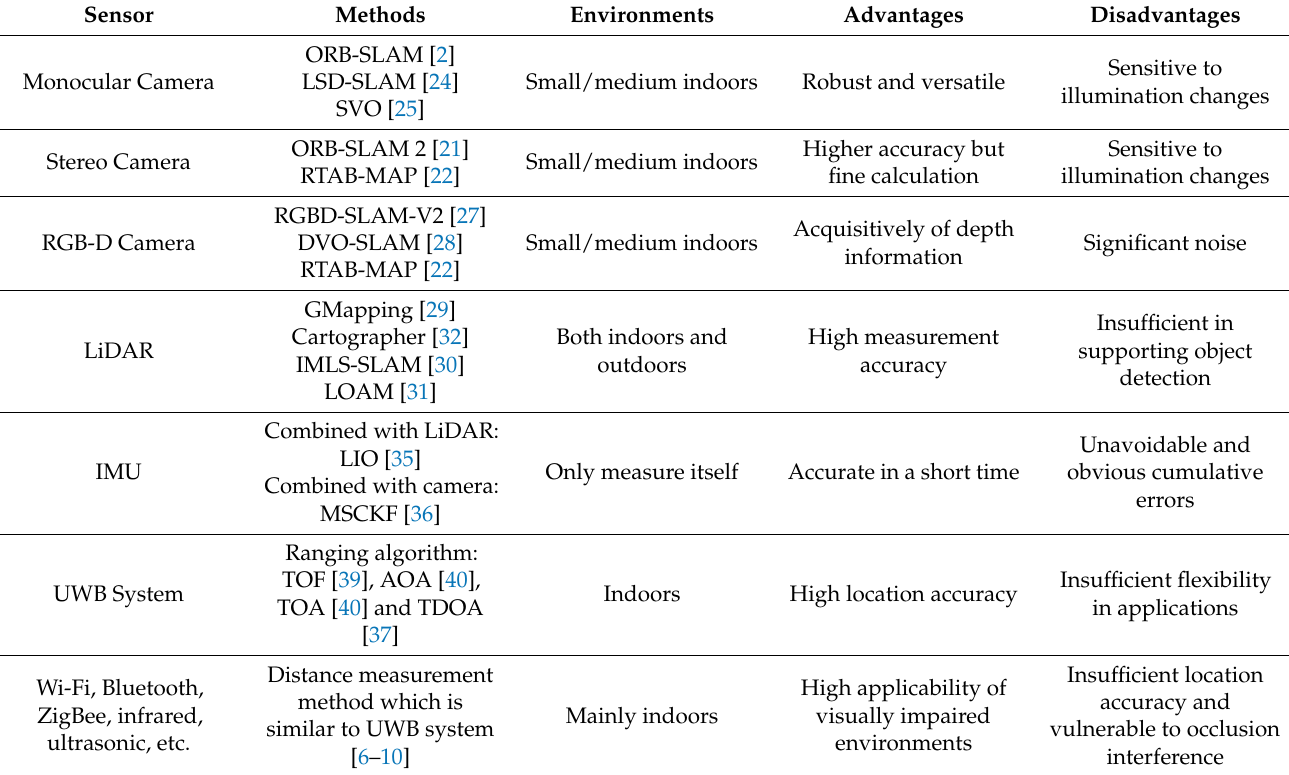
Table 1. List of single-sensor navigation